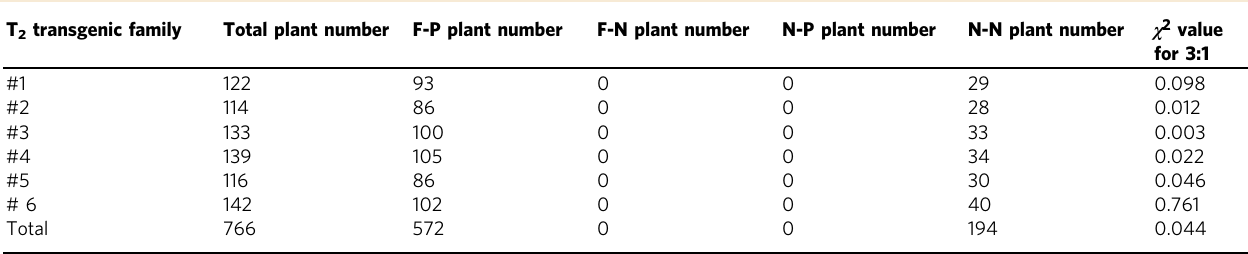
F-P indicates both fl uorescent and RT-PCR positive plants; N-N indicates neither fl uorescent nor RT-PCR positive plants; F-N indicates fl uorescent but RT-PCR negative plants; N-P indicates non fl uorescent but RT-PCR positive plants. The one-sided χ 2 test for 3:1 of F-P plants to N-N plants were conducted with signi fi cance level at 0.01. χ 2 1,0.01 =